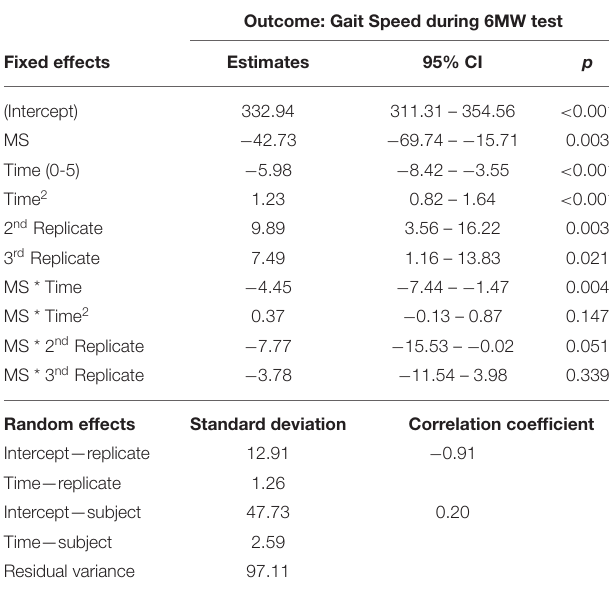
TABLE 1 | Summary statistics of the cross-sectional cohort. TABLE 2 | Results from the linear mixed-effects